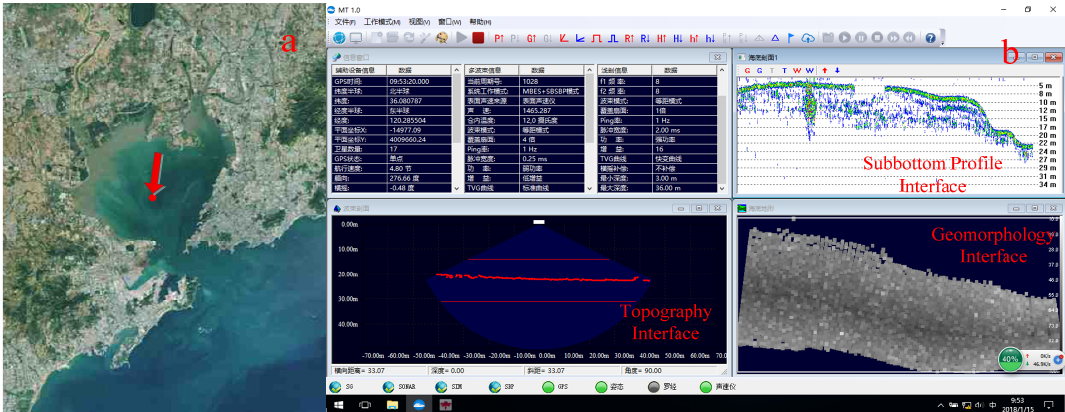
Figure 5. Portable seabed integrated detection system control software. ( a ) Experiment location in Jiaozhou Bay; ( b ) main software interface.